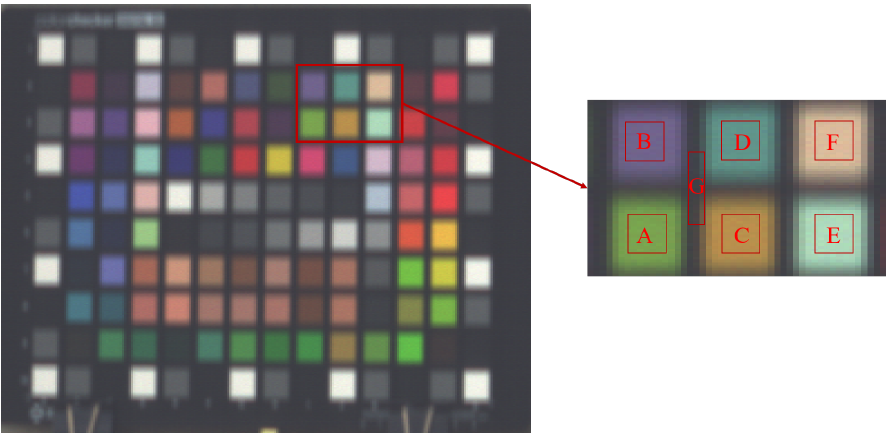
Figure 11. The colorchecker and the cropped subimage used for unmixing ( A – G denote seven kinds of endmebers in the subimage).